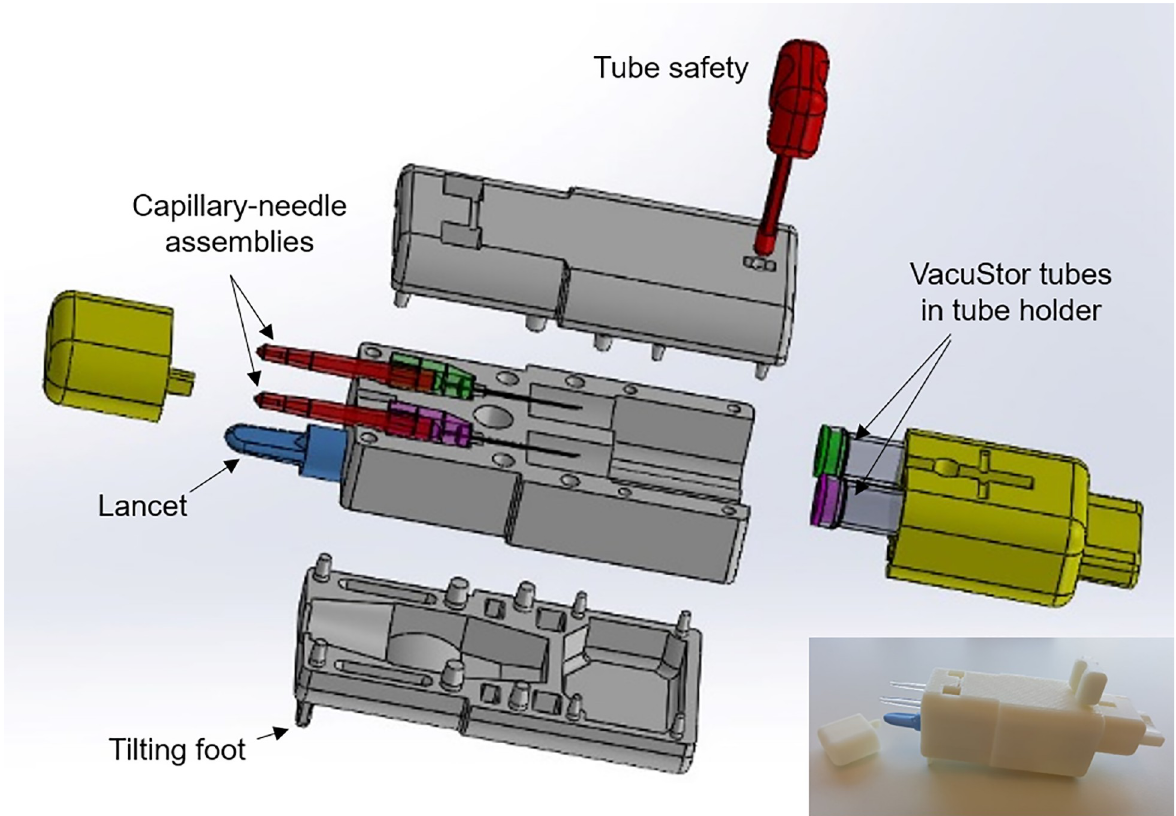
Fig 1. Design and prototyping of the integrated blood collector. Exploded view of the integrated blood collector, where one lancet, two capillary- needle assemblies and two VacuStor tubes are integrated by 3D printed parts; the insert shows an integrated blood collector prototype.